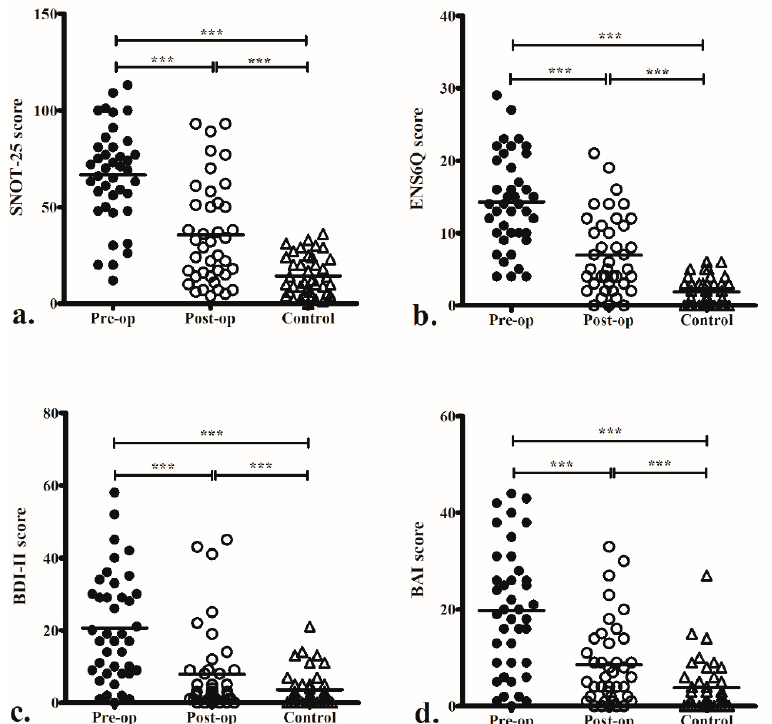
Figure 2. Preoperative (Pre ‐ op) and 1 year postoperative (Post ‐ op) 25 ‐ Item Sino ‐ Nasal Outcome Test (SNOT ‐ 25) ( a ), Empty Nose Syndrome 6 ‐ item Questionnaire (ENS6Q) ( b ), Beck Depression Inven ‐ tory ‐ II (BDI ‐ II) ( c ), and Beck Anxiety Inventory (BAI) ( d ) in patients with empty nose syndrome and the control group. *** p < 0.001. Table 2. Regression analysis for postoperative residual psychological